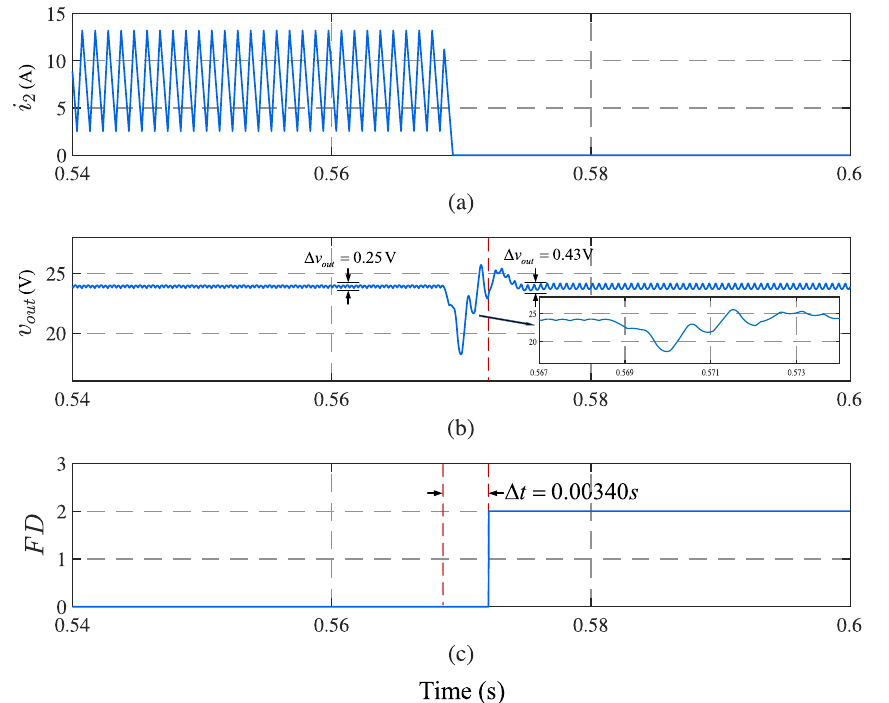
Figure 10. Waveforms after an OCF in branch 2 with the proposed method: ( a ) branch 2 current,